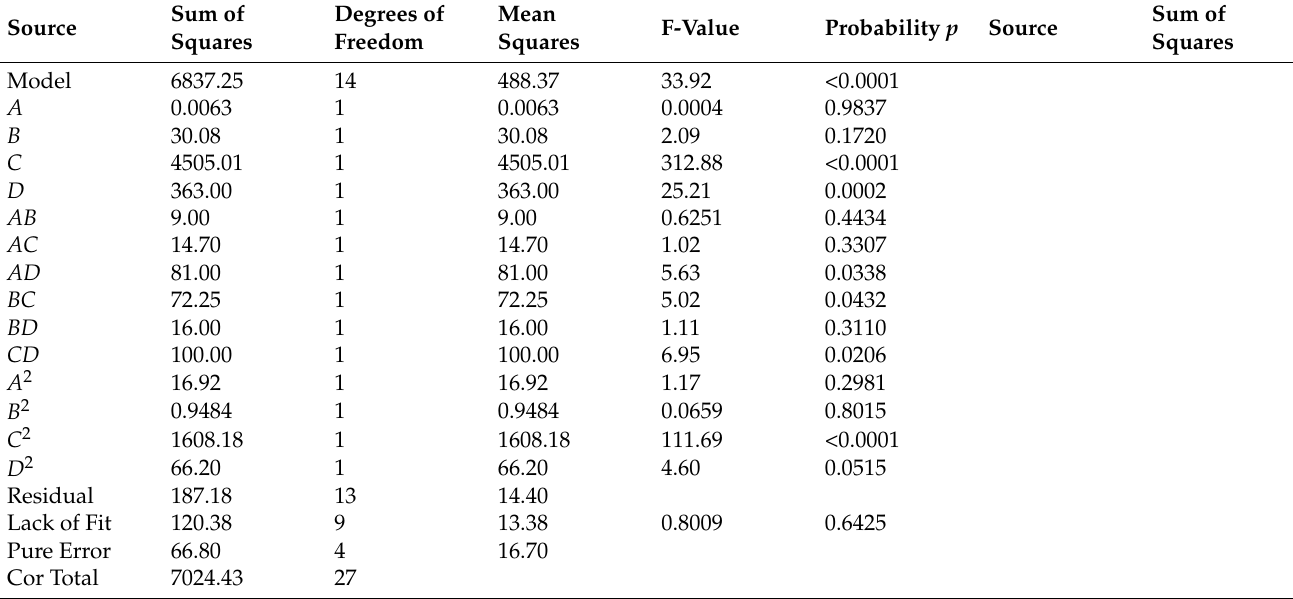
Table 3. Part of ANOVA for quadratic model.